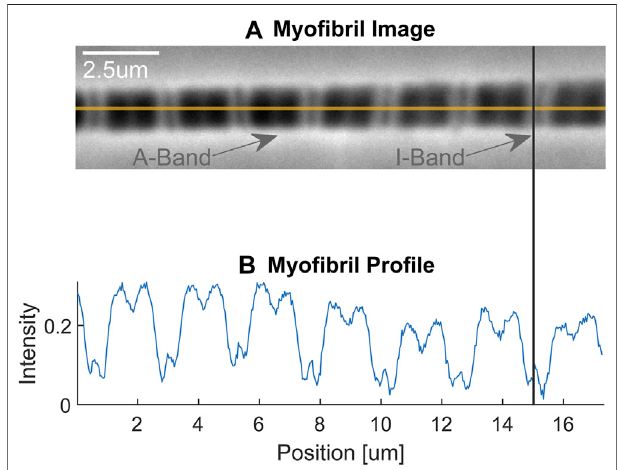
FIGURE2 | (A) Single myo fi bril with dark-lightstriation pattern.The dark areas represent the A-bands containing the thick (myosin) fi laments, while the light areas represent the I-bands containing the thin (actin) fi laments. The faint dark lineintheapproximate centreoftheI-bandsistheZ-linedelineating the end of the sarcomeres (indicated also with the vertical line connecting fi gures (A,B) . The myo fi bril is attached on its left-hand end to a rigid glass pipette, which in turn is attached to a piezo-tube motor that allows for nano- metre step size control (not shown) and is attached on its right-hand end to a silicon nitride nano-lever for force measurements (not shown). (B) Light intensity pattern of the myo fi bril shown in (A) . The dark, A-bands are given high intensity values, while the light, I-bands, are given small intensity values. Republished with permission of Royal Society, from Dynamics of individual sarcomeres during and after stretch in activated single myo fi brils. Rassier DE, Herzog W, Pollack GH. Proc. R Soc Lond Volume 270, p . 1735 – 1740. 2003; permission conveyed through Copyright Clearance Center